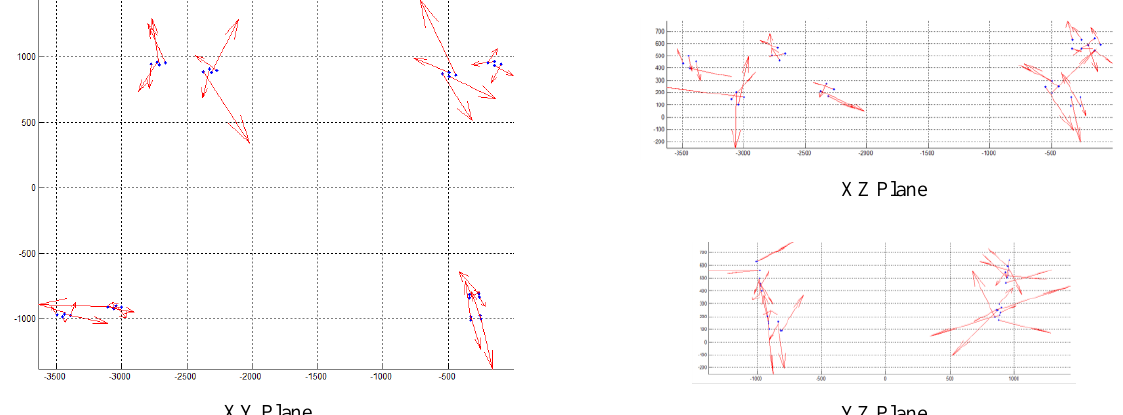
Figure 8. Spatial residuals in mm (scale: 1000) from the alignment through independent models